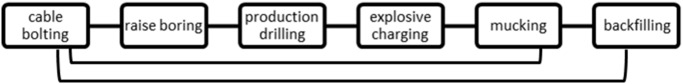
Operations of mobile mining equipment in mine production.